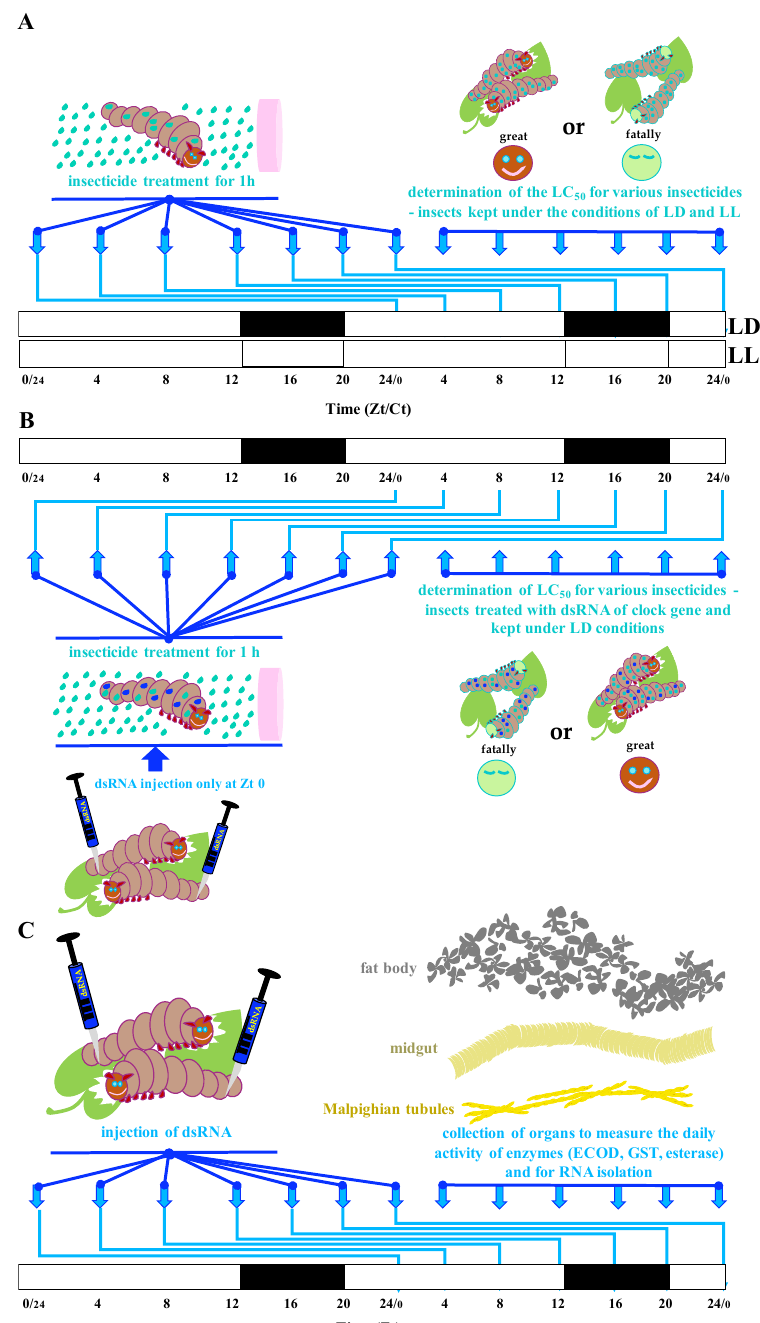
Scheme 1. Ways of conducting experiments. ( A ) Larvae kept under LD and LL conditions were treated with insecticides every four hours; caterpillar survival for LC 50 determination was monitored during the third day, i.e., 24 h after treatment with insecticides. ( B ) Treatment of larvae with dsRNA once at Zt 0, followed by treatment with insecticides every 4 h throughout the day; larval survival monitoring was performed every 4 h during the following day to collect data for determination of the LC 50 value. ( C ) The dsRNA of a given clock gene was injected into the body cavity of the insects at the same time points that the insects were treated with insecticides in the previous experiment; after 24 h, the fat body, midguts and Malpighian tubules were harvested for RNA isolation (for clock gene expression analysis) and monitoring of ECOD, GST, and esterase activity. Horizontal bars represent day (white) and night (black) portions of the photo-regime with Zt (Zeitgeber time)/Ct (Circadian time) indicated